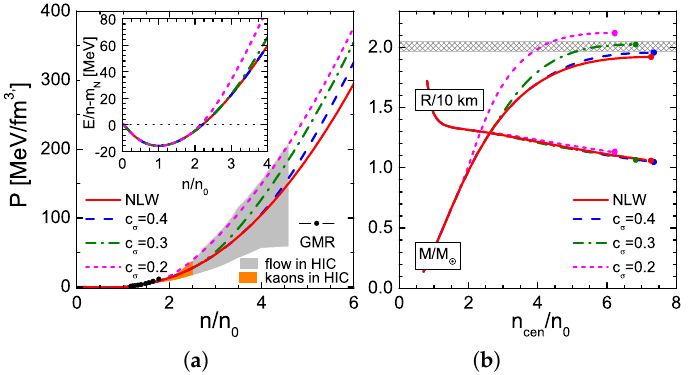
Figure 3. Figure from [12]. ( a ) total pressure P for the NLW and NLWcut models as a function of the nucleon density in the ISM for various values c σ ; the insertion demonstrates the binding energy per nucleon. Two shadowed areas show the constraints on the pressure from the particle flow and the kaon production data in heavy-ion collisions extracted in [2,3]. Bold dots show the extrapolation of the pressure consistent with the giant monopole resonance (GMR) description [3]; ( b ) the neutron-star mass and radius as functions of the central density for models under consideration. The hatched band denotes the uncertainty in the value of the maximum measured neutron-star mass 2.01